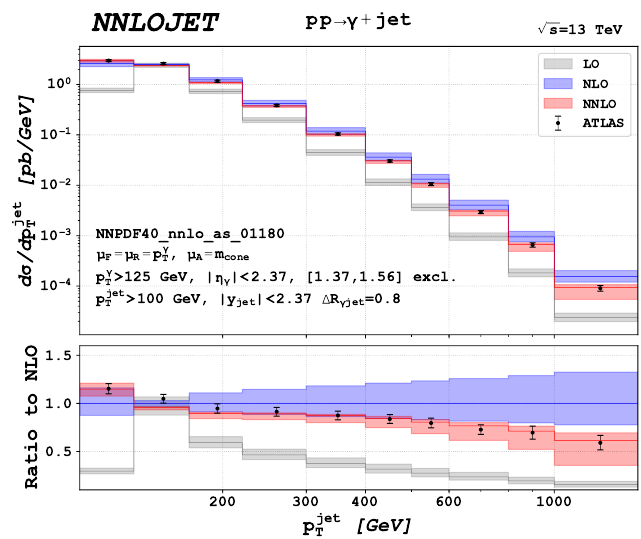
Figure 5. Predictions for the leading jet transverse momentum distributions at LO, NLO, and NNLO. The predictions are compared to data from the ATLAS measurement